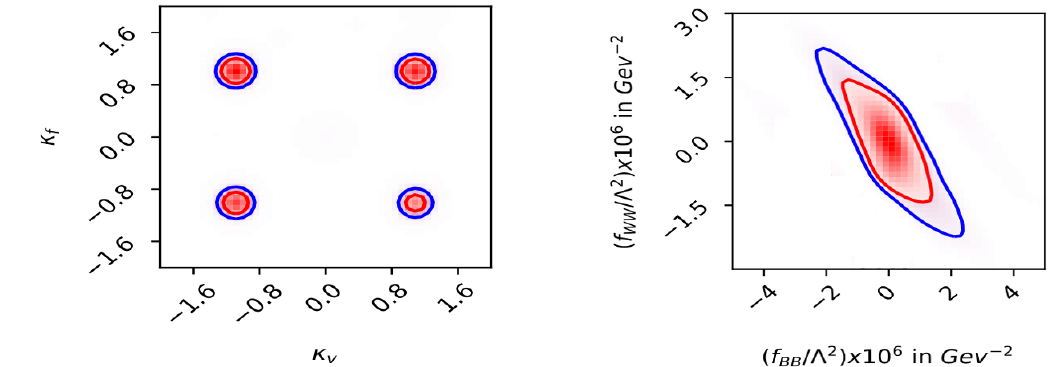
Figure 7 . Allowed regions at 1 (cid:27) (red) and 2 (cid:27) (blue) levels in the parameter space of scale factors and dimension-6 couplings in Type I